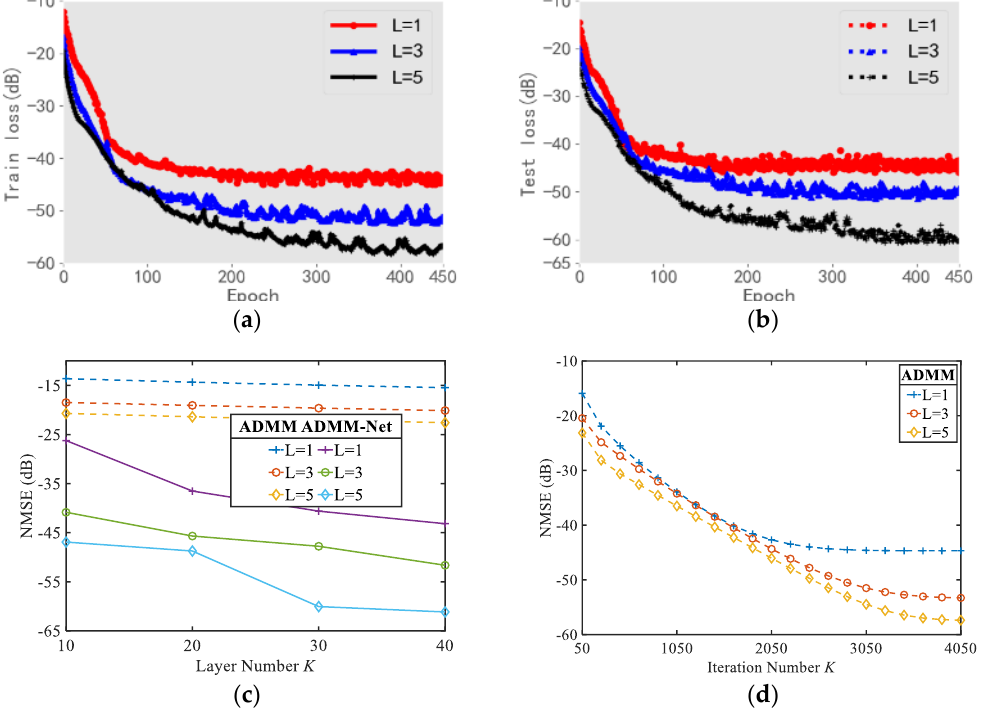
Figure 4. Convergence performance of ANM-ADMM-Net and its comparison with ANM-ADMM algorithm. ( a ) Train NMSEs when 10 M = ( b ) Test NMSEs when ( c ) Test NMSEs when algorithm. ( a ) Train NMSEs when M = 10 ( b ) Test NMSEs when M = 10 ( c ) Test NMSEs when K = 10 − 40 ( d ) Test NMSEs when K = 50 −